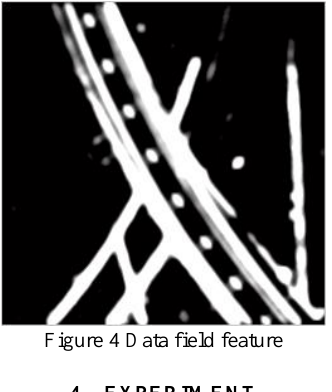
Figure 4 Data field